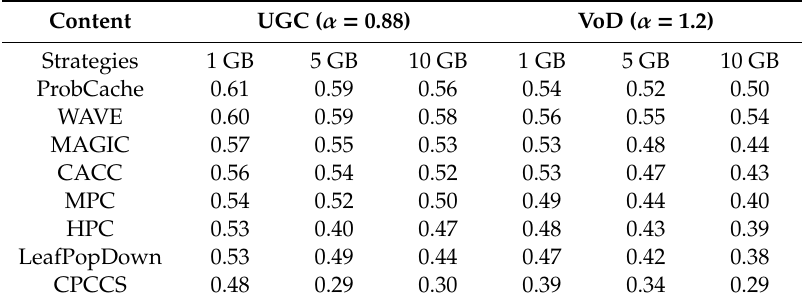
Table 3. Numerical values on